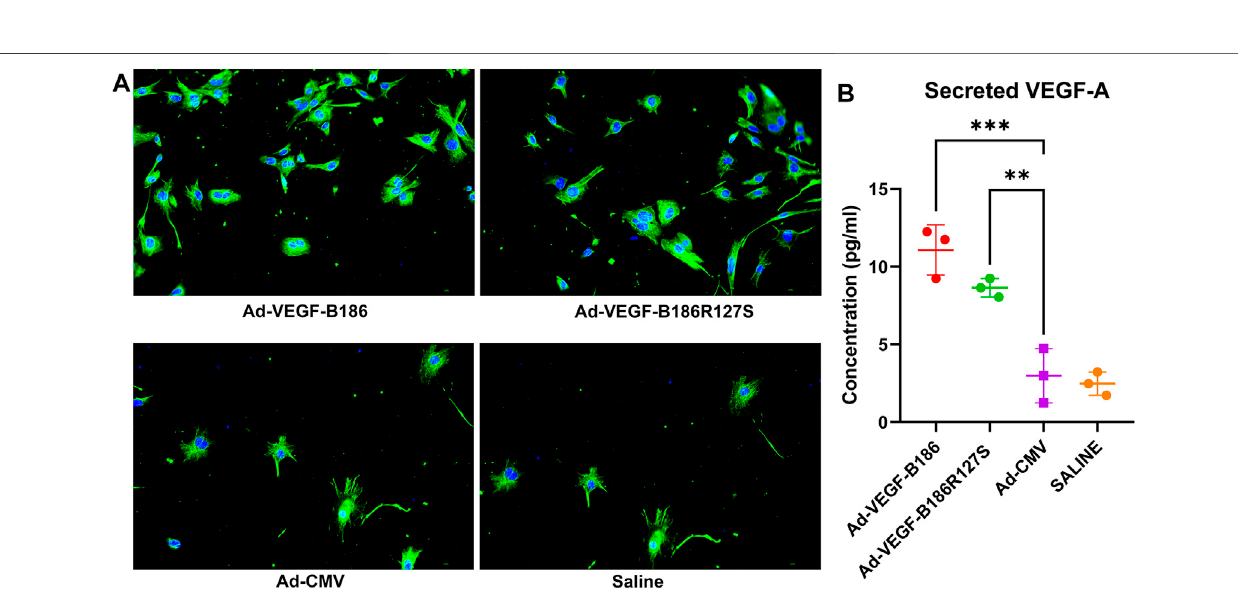
Frontiers in Bioengineering and Biotechnology |